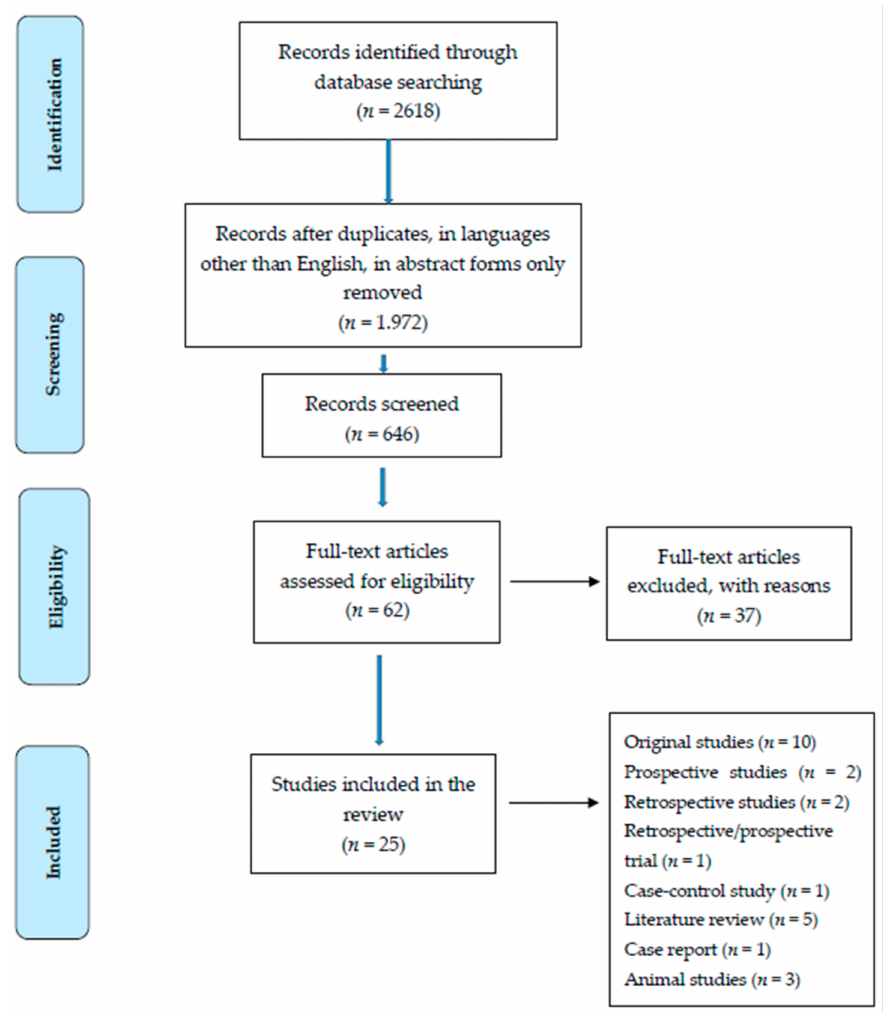
Figure 1. Flow chart presenting the process of searching for the eligible